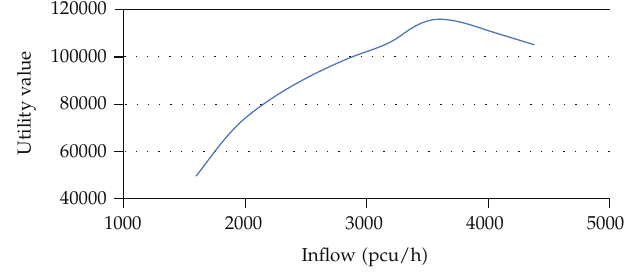
Figure 5: The relationship between utility value and inflow.